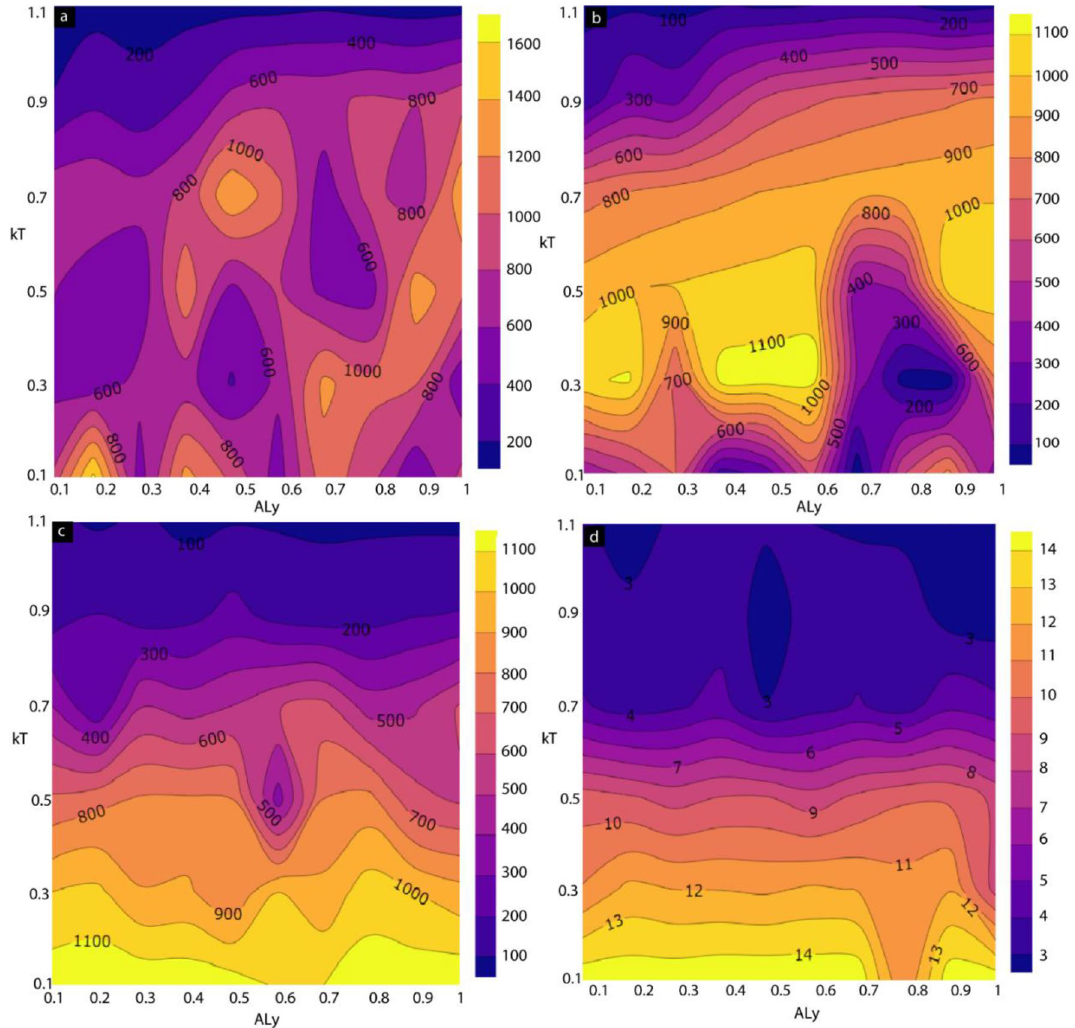
Figure 7. Magnetic moment of MTJMSD and its components was studied as function of thermal energy and easy axis anisotropy strength. Contour plot of ( a ) MTJMSD, ( b ) left FM electrode and ( c ) right FM electrode, and ( d ) molecular magnetic moment, as a function of in-plane anisotropy along y-spin direction and thermal energy ( kT ).